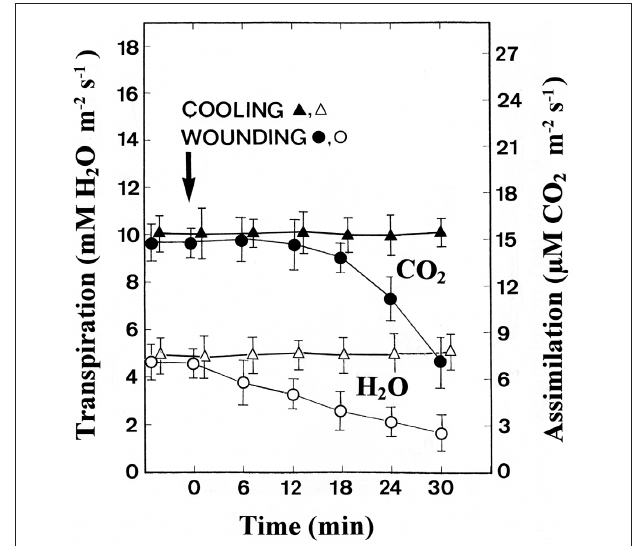
FIGURE 2 | Changes in the assimilation (CO 2 ) and transpiration (H 2 O) rate after stimulation of the leaf tips by cooling or wounding. Data are mean values ± SE from 10